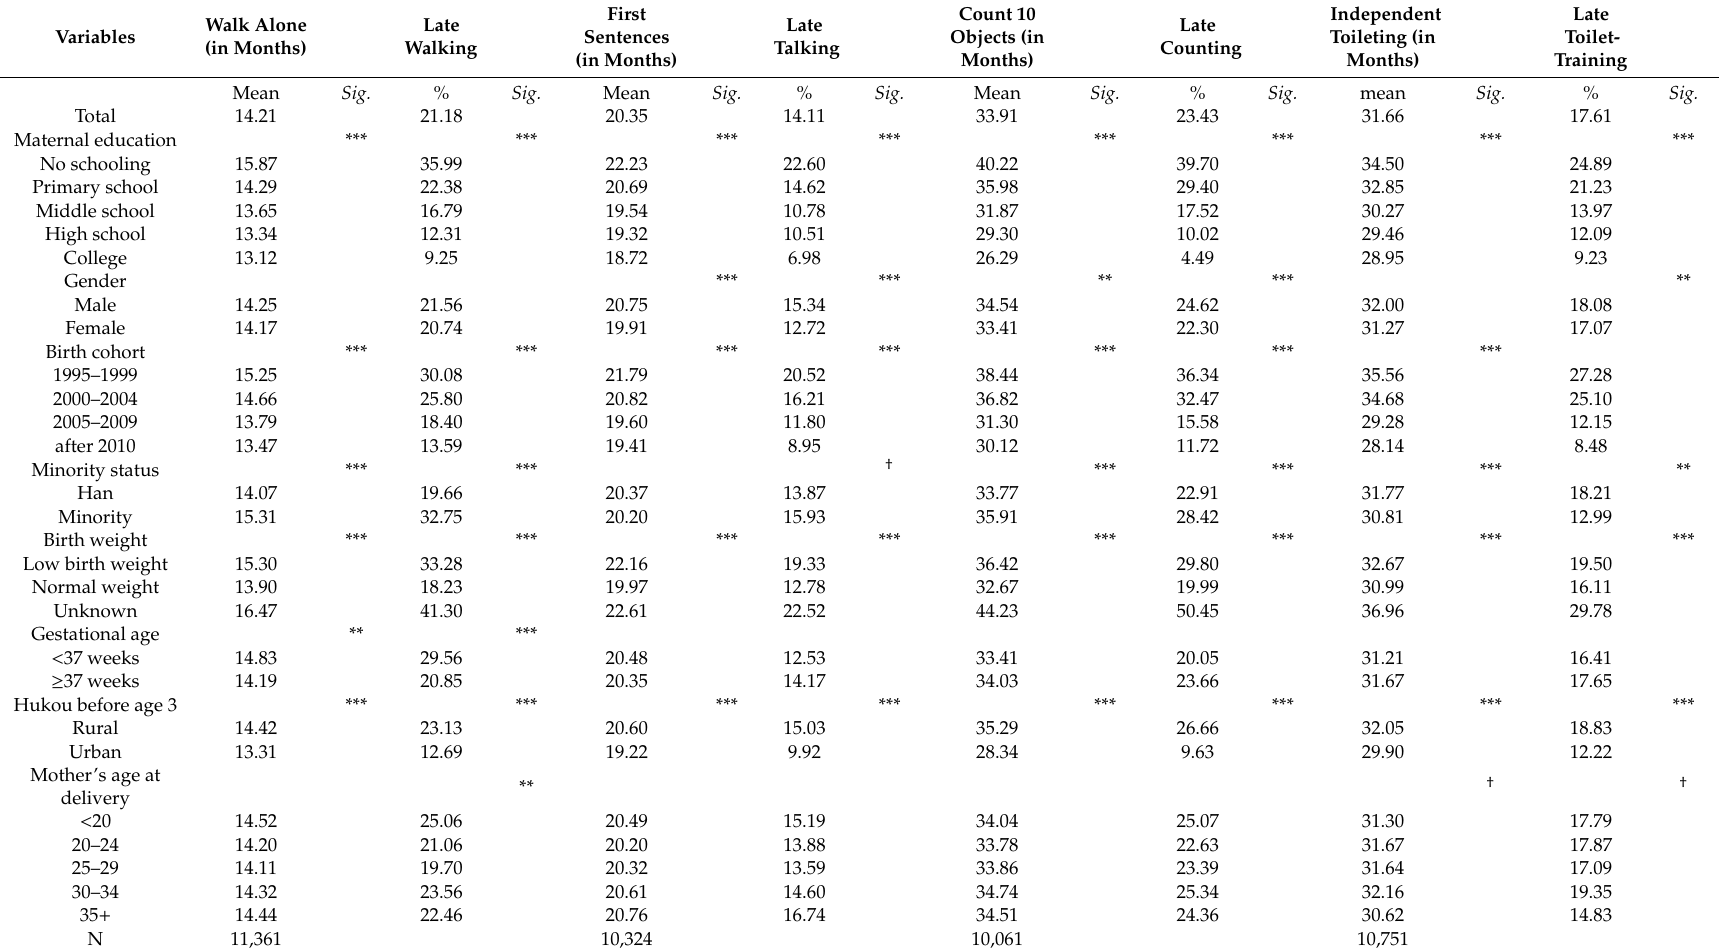
Table 1. The attainment of developmental milestones by explanatory